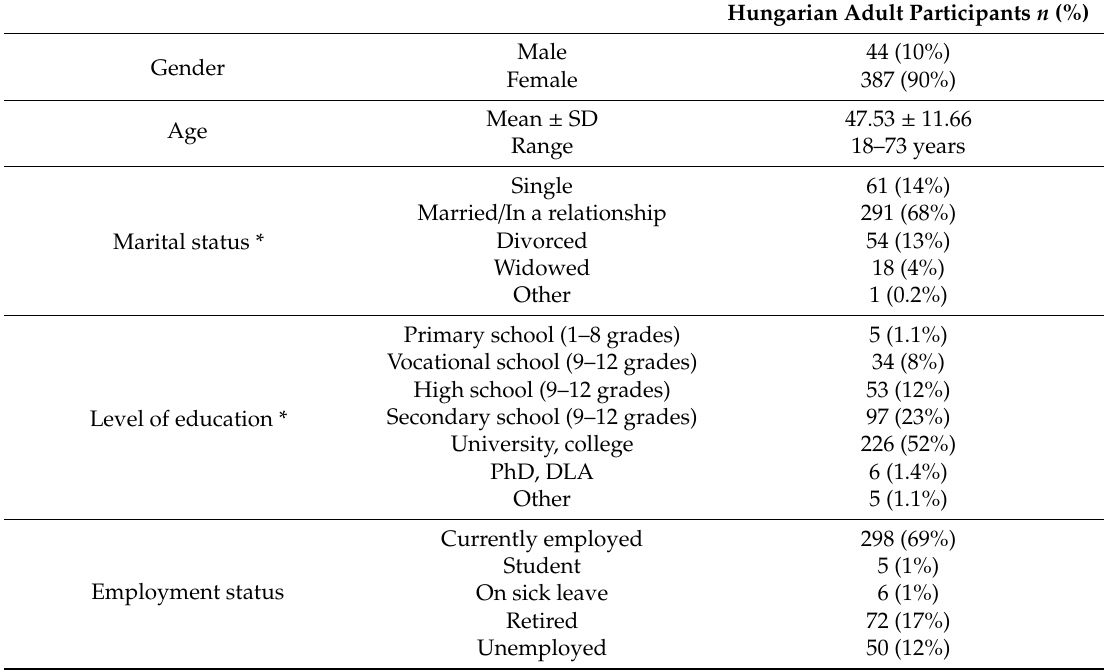
Table 2. Participants’ attributes ( n = 431). Optionally answerable items of the questionnaire were marked with a *